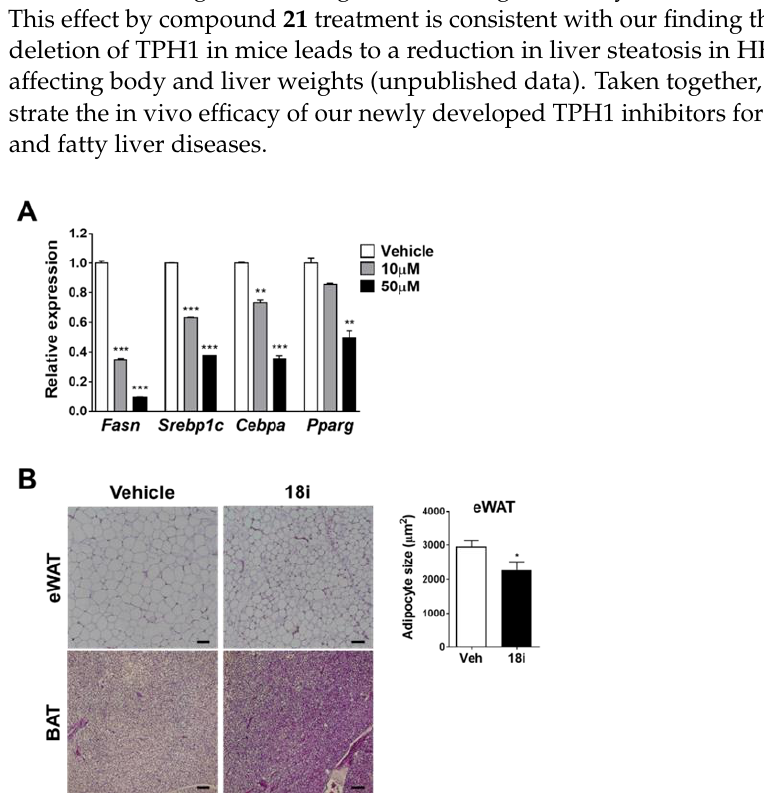
Figure 3. Compound 18i protects against diet-induced obesity. ( A ) Lipogenic gene expression in 3T3-L1 cells treated with vehicle or 18i at the concentration of 10 μM or 50 μM. This experiment was repeated as biological triplicates with similar results ( B ) Representative haematoxylin and eosin (H&E) images of epididymal WAT (eWAT) and brown adipose tissue (BAT) from HFD-fed mice treated with vehicle or compound 18i -treated for 10 days (left, scale bar is 100 μm). Average adipocyte cross-section area of eWAT measured from H&E images (right). * p < 0.05, ** p < 0.01 and *** p < 0.001 vs. vehicle by Student’s t -test. Data are presented as mean ± s.e.m.